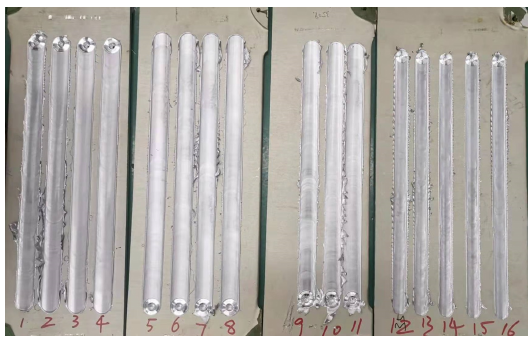
Figure 8. Experiment Platform.